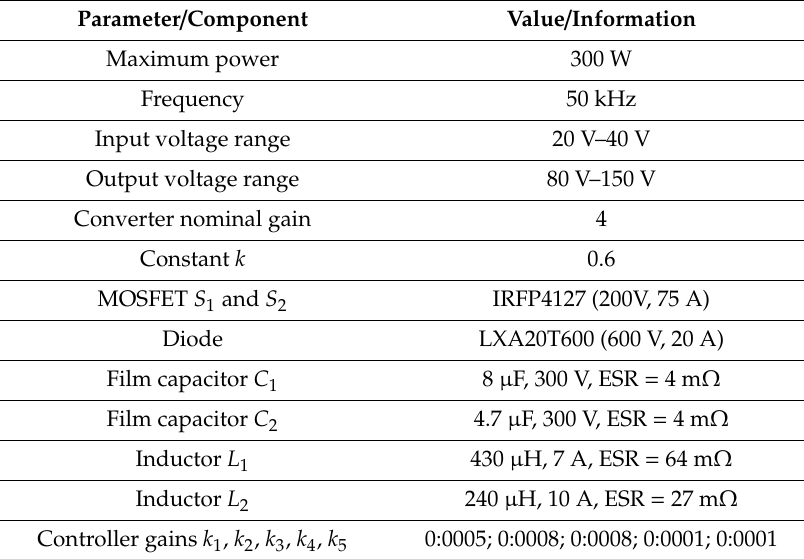
Table 2. Experimental setup parameters.